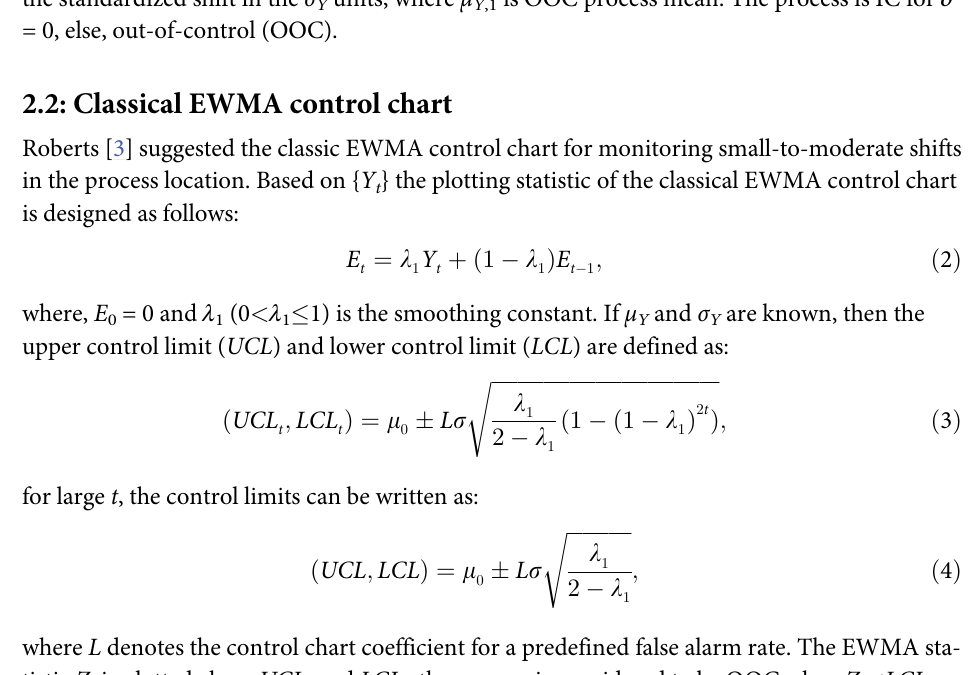
p ð 1 (cid:0) r 2 Þ and known as